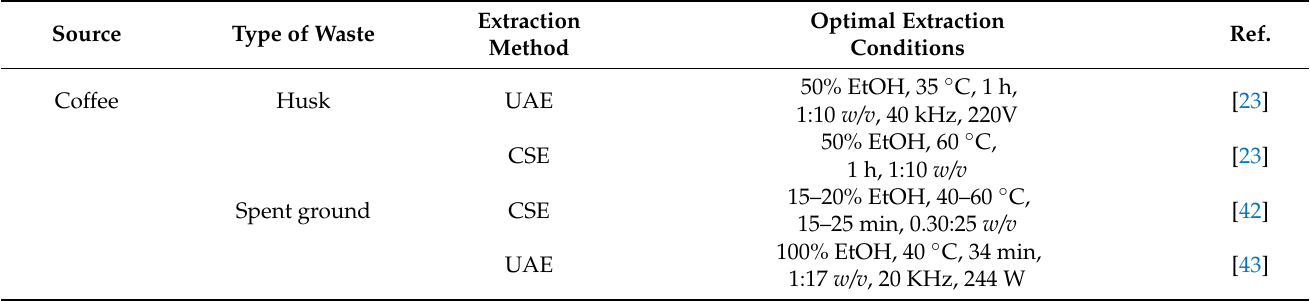
Table 2. Overview of the most relevant green extraction methods and related optimal extraction conditions for CGAs recovery from agri-food